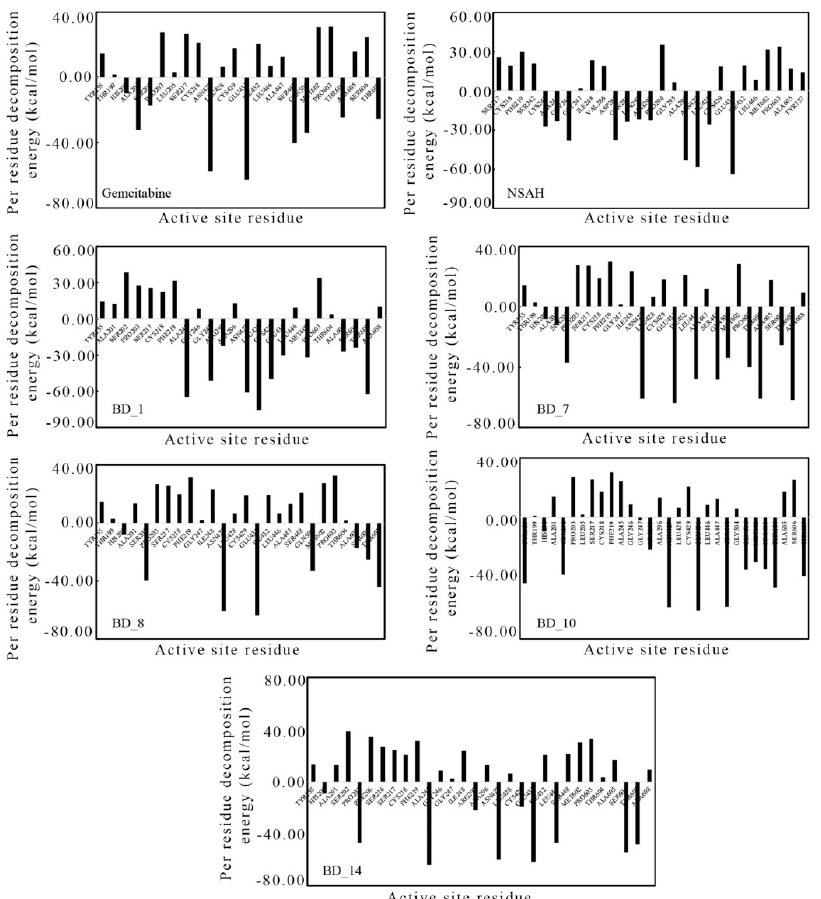
Figure 11. Per-residue decomposition energy of hRRM1 amino acids present around 5 Å of bound ligand.